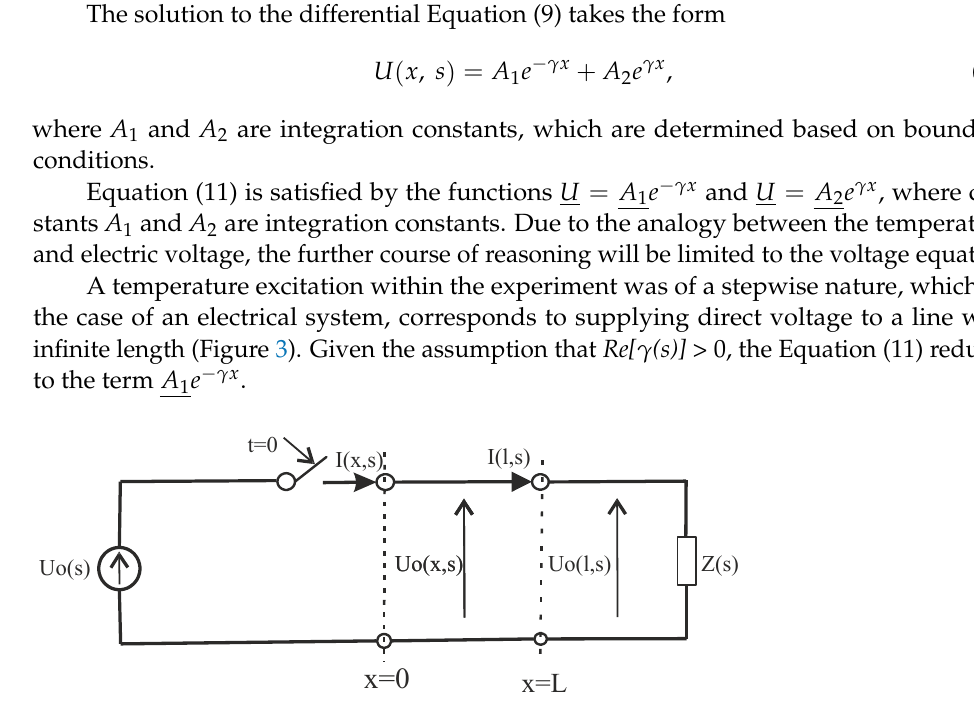
Figure 3. Supplying DC voltage to a line of infinite length.